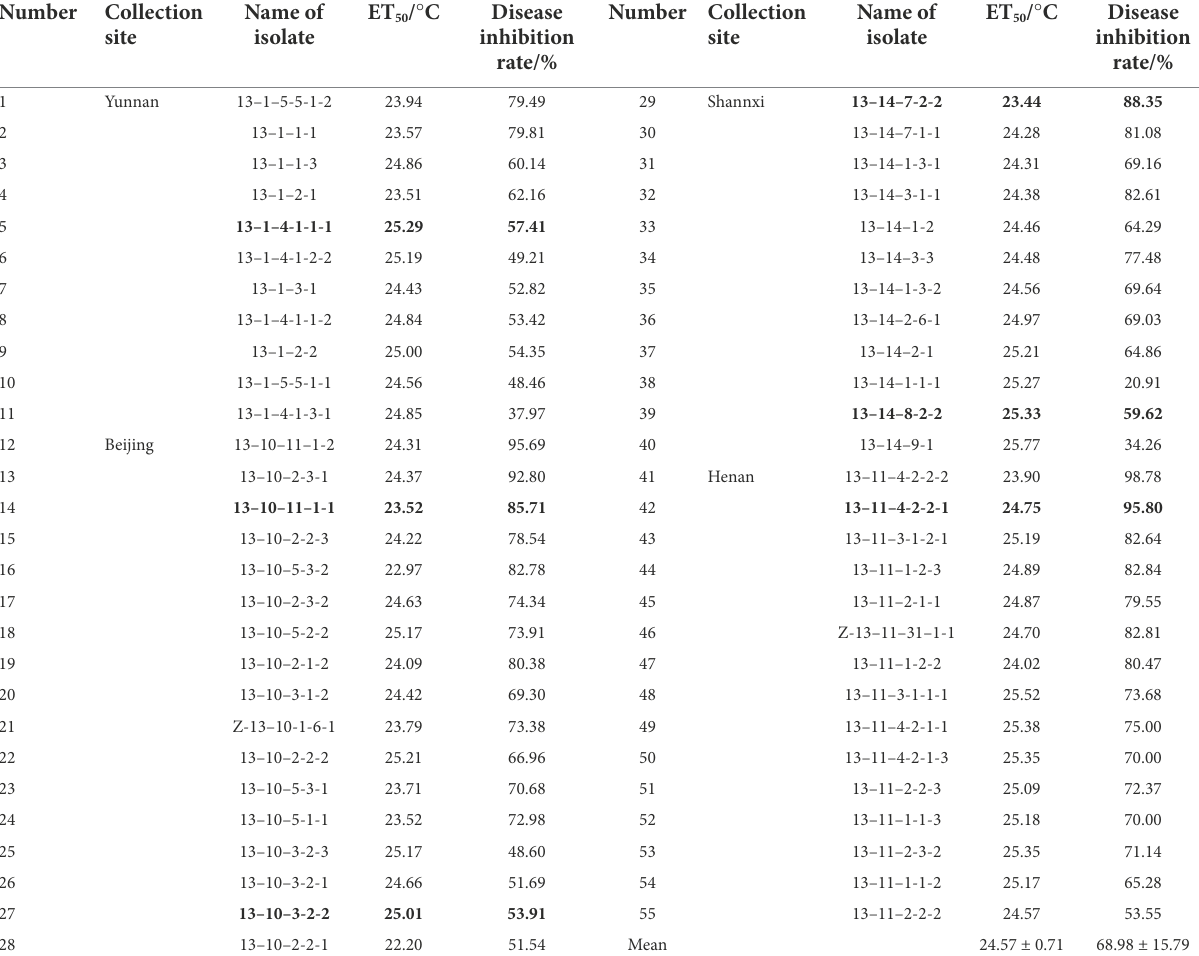
TABLE 3 ET 50 and disease inhibition rate (DIR) at 26 ° C of 55 B. graminis f. sp. tritici